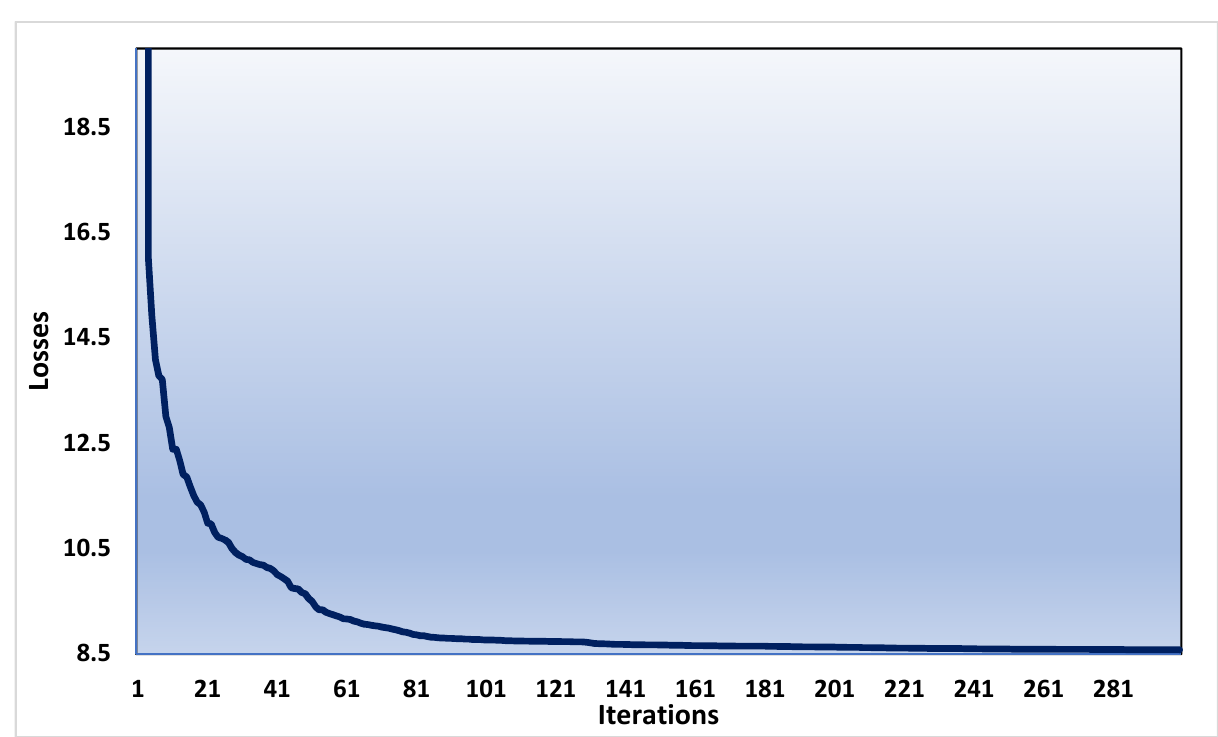
Figure 3. Convergence curves of TLBA for the minimization of the ETLs of the IEEE 30-bus network. Also, for the minimization of the ETLs, Table 5 tabulates comparative results with various reported techniques of CSA [30], PSO [56], MVO [34], MPO [56], IMPO [34] and MRFO [30]. This table deduces the great superiority of the proposed TLBA in finding the least ETLs of 8.5827 MW where CSA, PSO, MVO, MPO, IMPO and MRFO [30] obtains ETLs of 9.57, 9.078, 9.005, 8.75, 8.66 and 8.5704 MW. The accepted level of accuracy, in terms